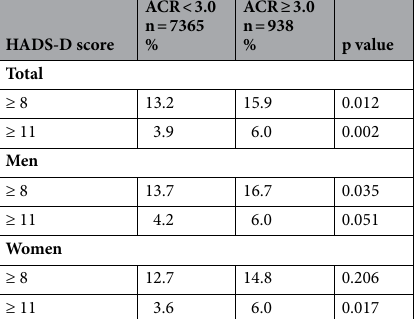
Table 2. Prevalence of depression (HADS-D ≥ 8 and ≥ 11) in subgroups with or without albuminuria (ACR < and ≥ 3.0 mg/mmol), in the total population and stratified by sex. ACR; albumin/creatinine ratio.